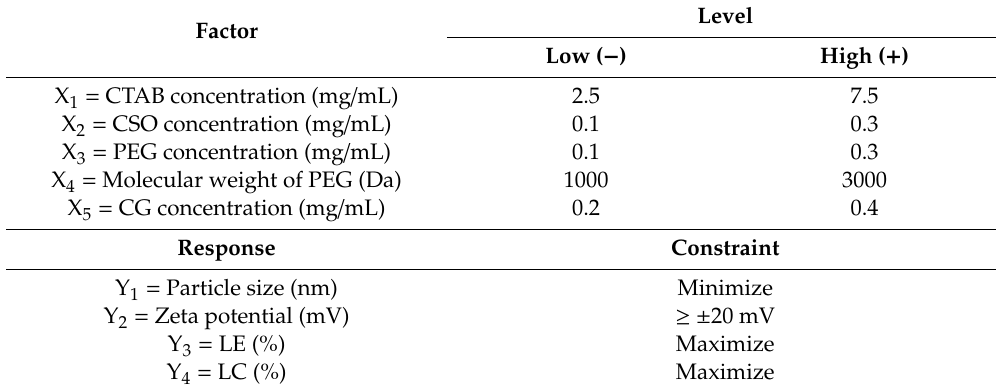
Table 1. Factors and responses of CG-PEG-CSO-SPIONs in the PBD.